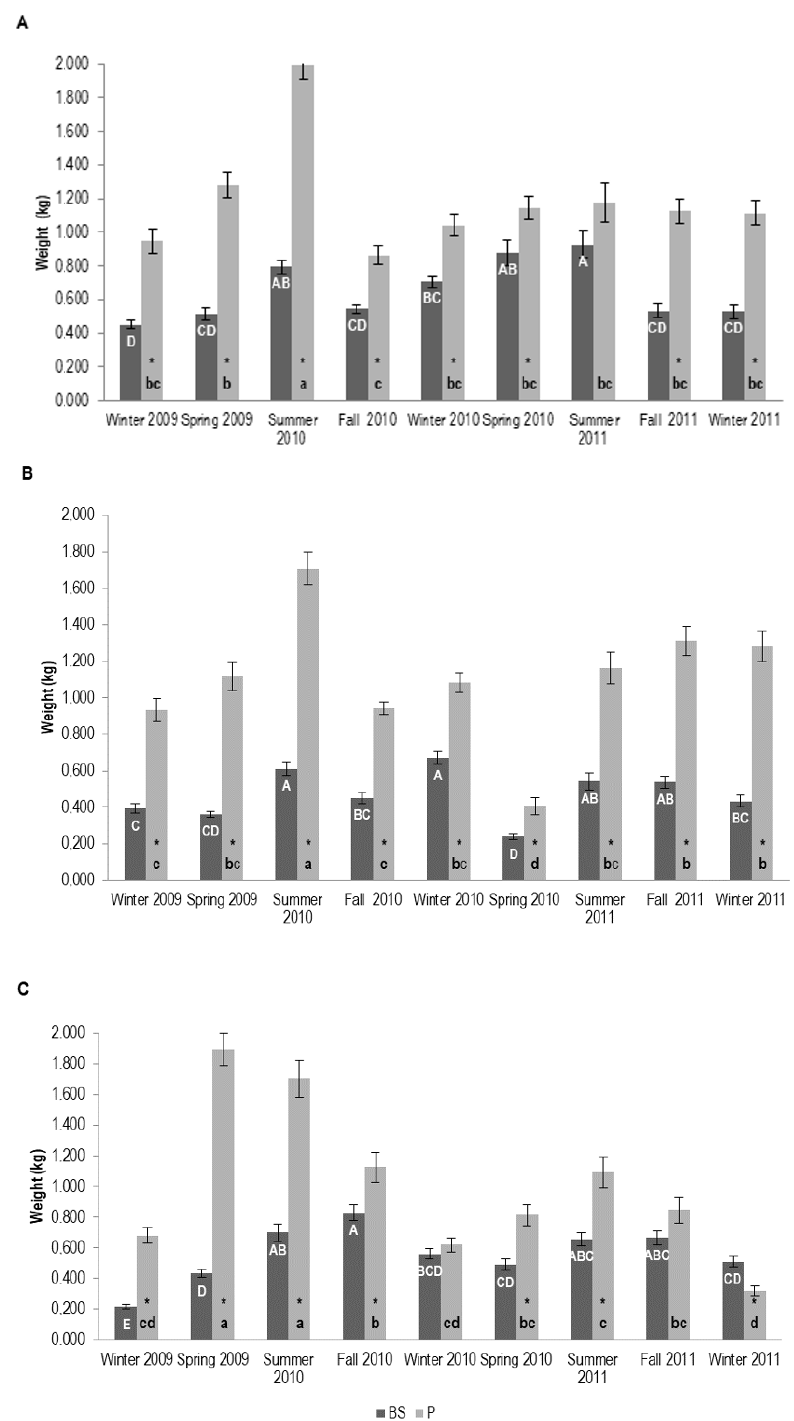
Figure 2. Seasonal resin production in three different slash pine plantations. ( A ) (Site A): 14-, ( B ) (Site B): 24-, ( C ) (Site C): 26-year-old stands (age at the installation of the experiments). Uppercase and lowercase letters compare resin yield within bark streak (BS) and paste (P) treatments, respec- tively, through different seasons from winter 2009 to winter 2011. Bars sharing a letter are not sig- nificantly different by the Tukey test ( p ≤ 0.05). * Indicates the significant statistical difference be- tween BS and P treatments in the same season by t-test ( p ≤ 0.05). Note that in the southern hemi- sphere, the year change occurs during summer. This season commences either on December 21st or 22nd, depending on the summer solstice. The most productive seasons for resin yield were spring and summer in the first crop year of the sites analyzed (Figure 2A–C). In contrast, in the second crop year, these seasons were not as productive (Figure 2A–C). The highest amount of chemically induced resin was found at site A in the summer of 2010 (1.997 kg per paste-treated tree) (Figure 2A). In the second crop year (from winter 2010 to winter 2011), the induced resin yield was similar